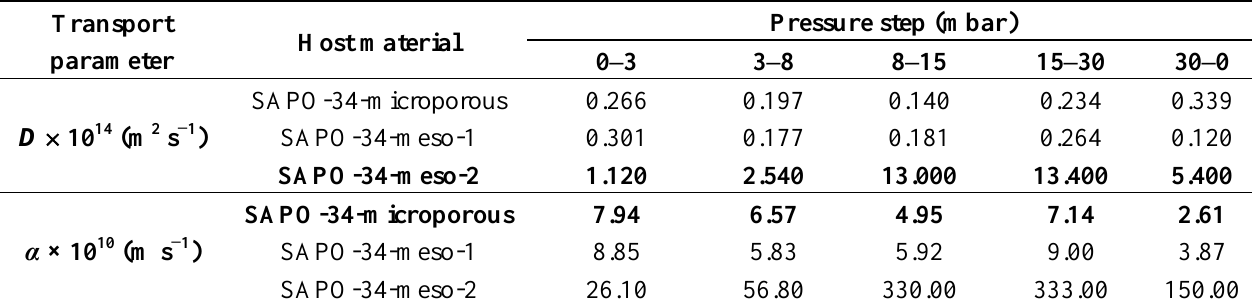
Table 2. Fitting parameters used for the representation of the analytical expressions shown in Figure 4 for diffusion-limited ( D in Table 2, fit to Equation 1) and for barrier-limited ( α in Table 2, fit to Equation 2) uptake and release of propene in various specimens of SAPO-34 at 298 K, as a function of the pressure step. Fitting parameters which, by comparison between experimental measurement and theoretical dependence, may be considered as physically meaningful quantities ( i.e. , intraparticle diffusivities or surface permeabilities) are printed in